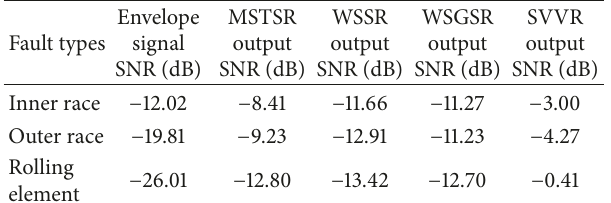
Table 3: SNRs with various bearing fault types processed by different WSD